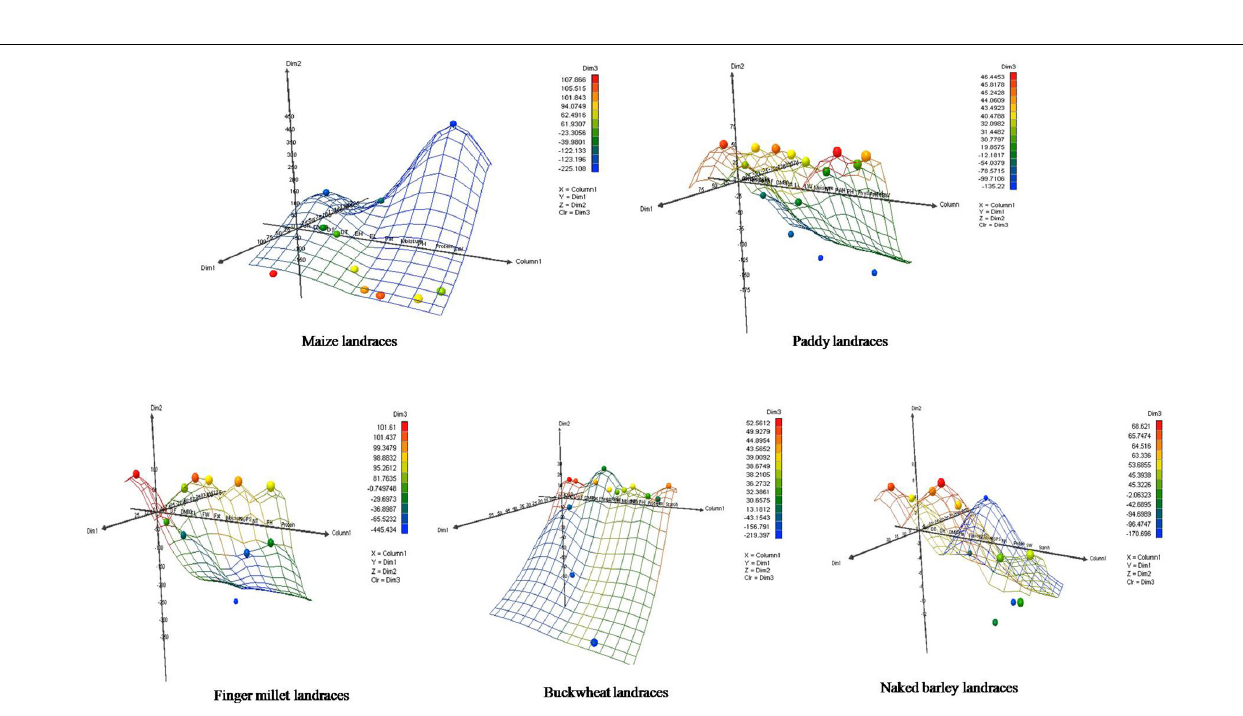
Frontiers in Plant Science |